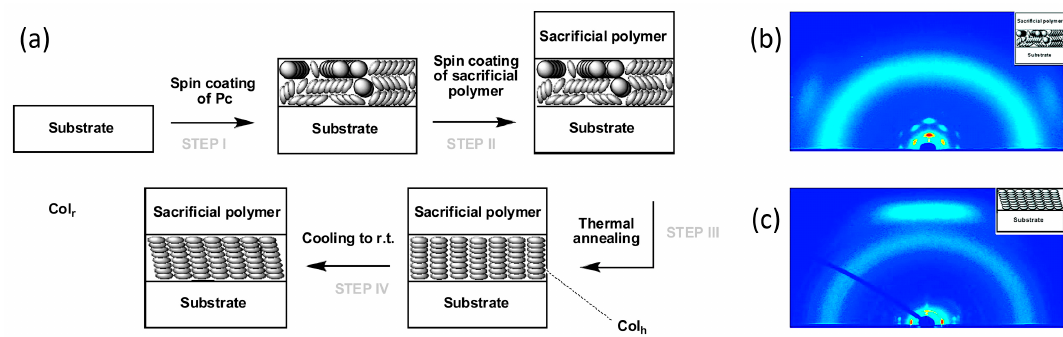
Figure 6. The alignment of hexagonally ordered liquid crystals by coating with a sacrificial polymer. ( a ) Schematic of the steps taken to align a Col hex LC film on a solid substrate; ( b , c ) 2D grazing incidence X-ray diffractograms of LC film before ( b ) and after ( c ) the homeotropic annealing step. Reprinted (adapted) with permission from [61]. Copyright 2009 American Chemical Society.